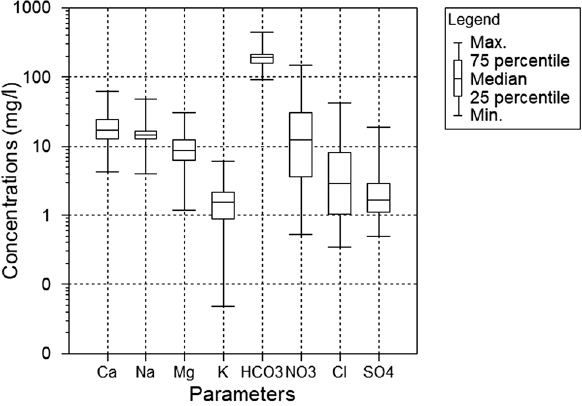
Fig. 4 Box and Whisker plot of major cations and anions in the